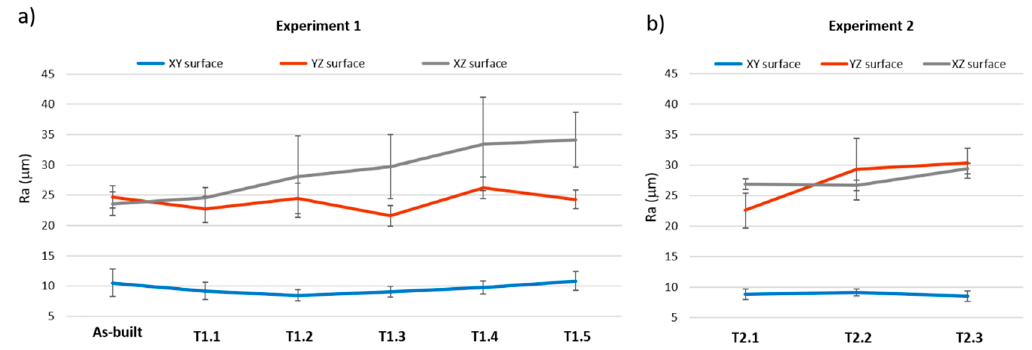
Figure 11. Surface roughness in the testing points for both thermal treatments. ( a ) Experiment 1; ( b ) Experiment 2.